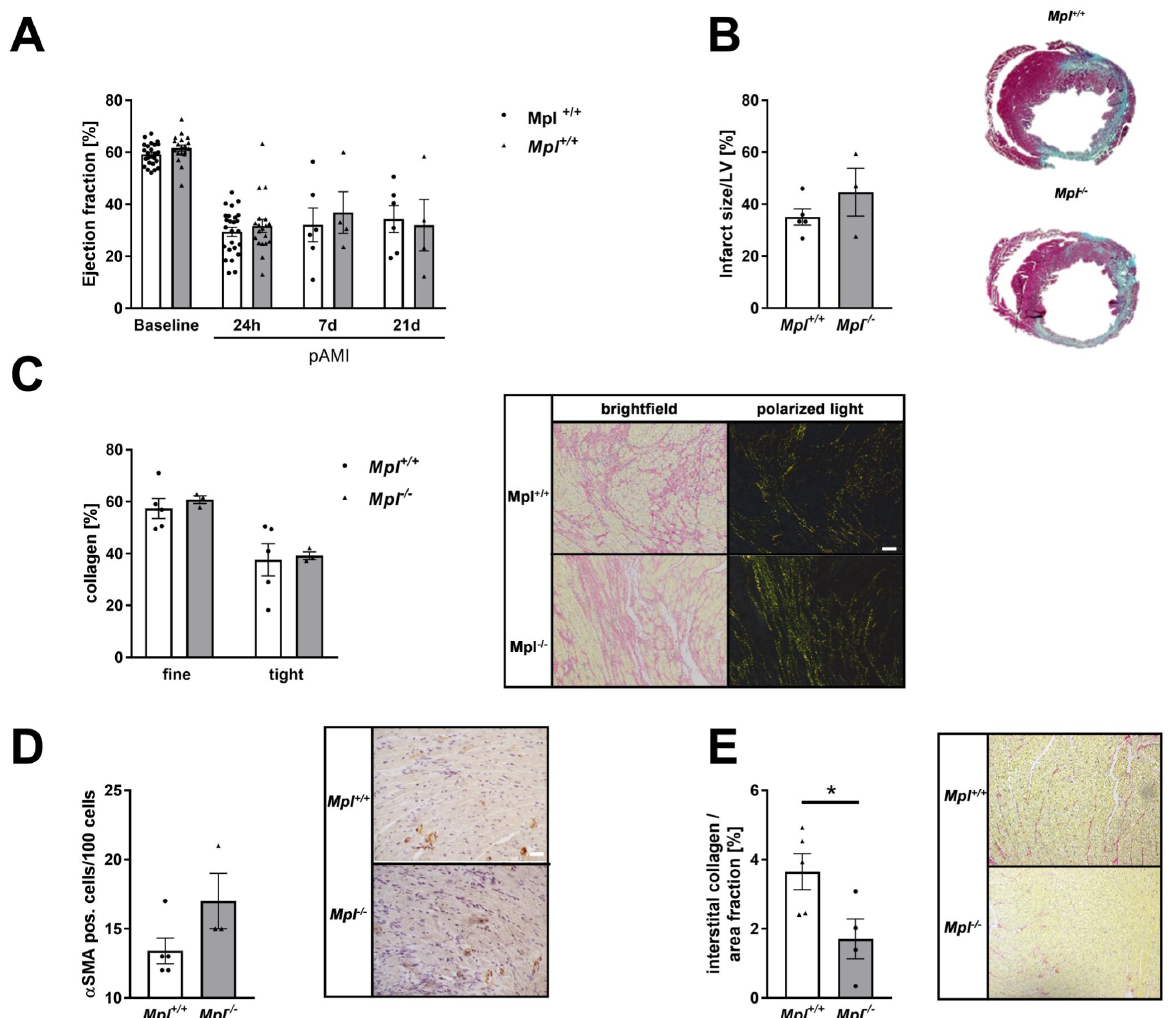
Figure 7. Unaltered collagen composition and LV function in MPL deficient mice after I/R. ( A ) Echocardiographic analysis of cardiac function by determination of ejection fraction (baseline vs. 24 h, 7d and 21 d after I/R) of MPL deficient and control mice; n = 19–25 (basline and 24 h post AMI), n = 5 (7d and 21d post AMI). ( B ) Quantification (left panel) and representative images of scar size (right panel) using gomori‘s trichrome staining 21 days post AMI. n = 3–4. Infarcted area is stained in blue and healthy tissue is stained in red. Data are presented as means ± SEM. ( C ) Analysis of collagen composition (left panel) and representative images of sirius-red staining (right panel) of MPL deficient and control mice after 21 days of reperfusion; n = 3–4. ( D ) Quantification of α SMA positive cells in the infarcted myocardium of MPL deficient mice after 21 days of reperfusion compared to control mice; Quantification (left panel) and representative images (right panel). n = 4. ( E ) Quantification (left panel) and representative images (left panel) of sirius-red staining of interstitial collagen in the remote zone of MPL deficient and control mice after 21 days of reperfusion; n = 5–9. Scale bar = 50 µ m. Statistical analyses were done by Two-Way ANOVA followed by Sidak post hoc. * p <